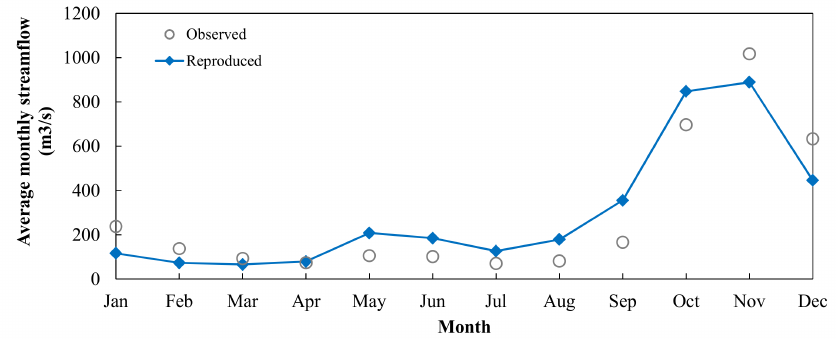
Figure 7. Average monthly observed and reproduced streamflow for the upper Thu Bon River basin at Nong Son in the period of